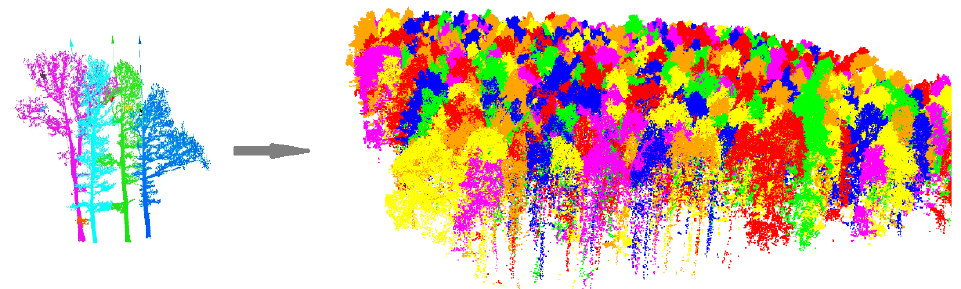
Figure 6. The results of segmentation algorithm: the left shows the algorithm demonstration of a small batch of samples, and the right figure shows part of the segmentation results, which is rendered into different colors to distinguish individual trees.